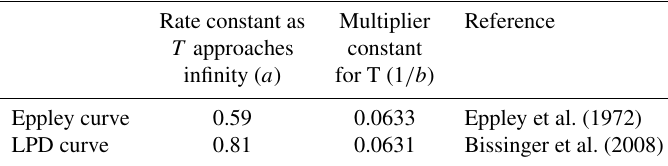
Table 1. Values for variables in Eq. (4).